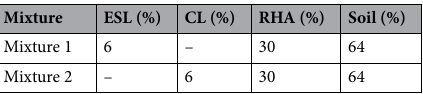
Table 5. Mixtures composition.